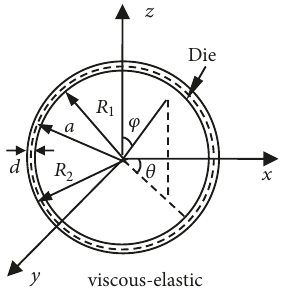
Figure 1: A spherical biogas digester in viscoelastic